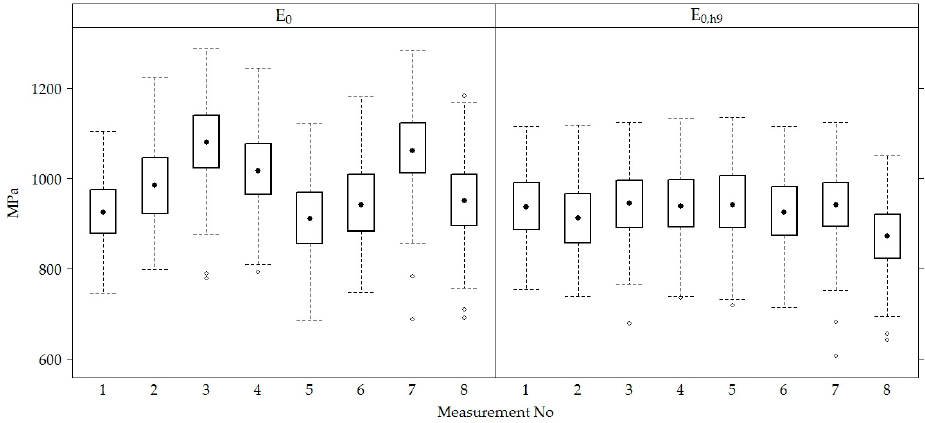
Figure 16. The box-plots of the distribution of individual E 0 and E 0,h9 values of the tested